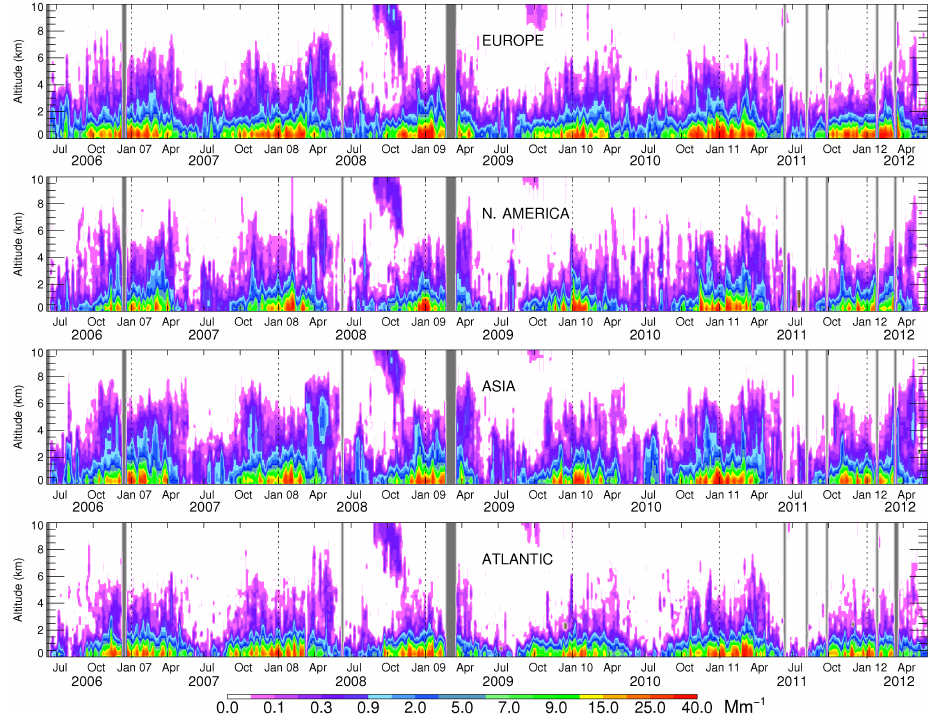
Fig. 12. Timeseries of 5-day-mean nighttime-equivalent CALIOP extinction as a function of altitude for the four Arctic sectors poleward of 65 ◦ N. Grey vertical bars indicate CALIOP data